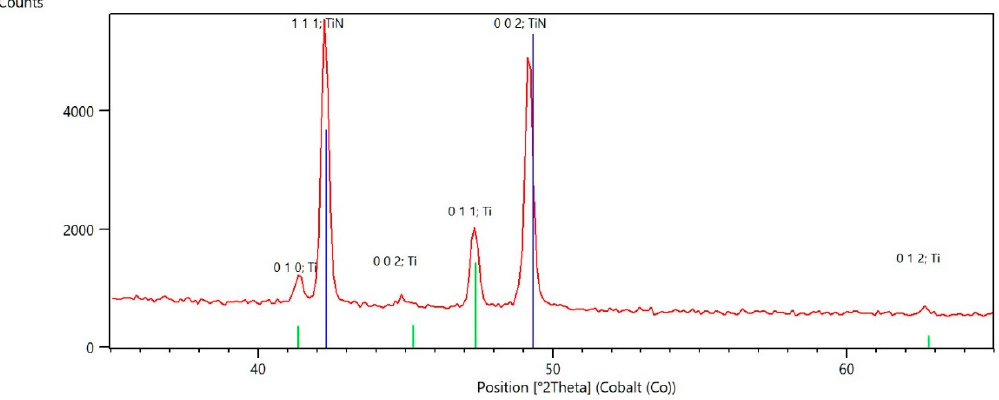
Figure 2. X-ray diffraction pattern for nitrided sample. Ti hexagonal alpha phase and surface layer of cubic TiN were detected.